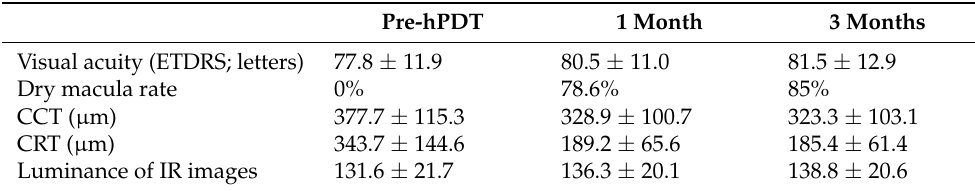
Figure 2. Changes in the mean luminance of IR images at 1 and 3 months after hPDT. Luminance was 64.4% before hPDT, rising to 54.4% at 1 to 3 months after treatment. Compared with the pretreatment value, luminance of IR images was significantly increased at 1 and 3 months after treatment and tended to improve with time at 1 and 3 months after hPDT. Table 2. Results of visual acuity, dry macula rate, CCT, CRT and luminance of IR